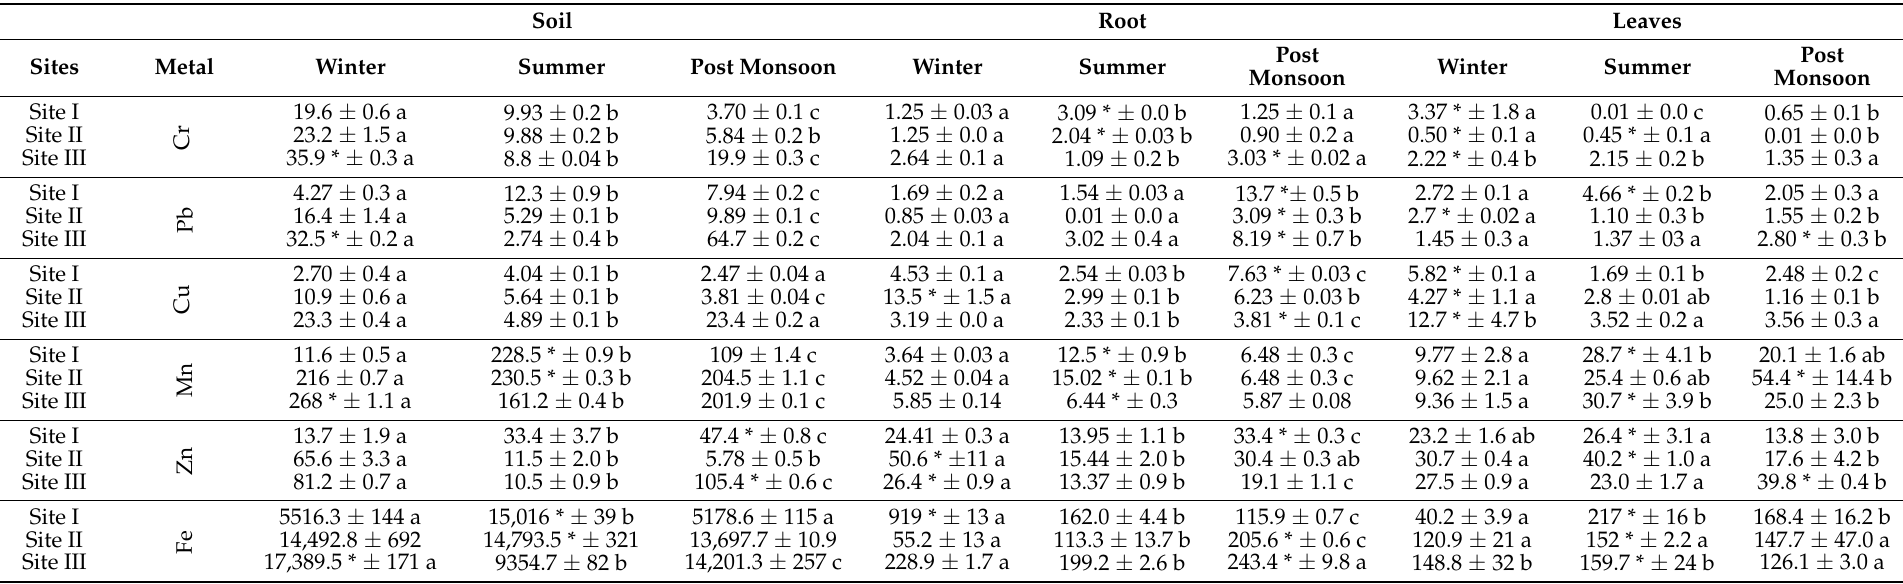
Table 1. Extractable metal concentration (mg kg − 1 ) in soil, root, and shoot of Salvadora persica at Sandspit (Site I), Clifton (Site II) and Korangi (Site III). Different letters on error bars indicate significant differences among seasons on the same site ( n = 3) at p ≤ 0.05 (Bonferroni/Games-Howell tests wherever applicable). Asterisk (*) in mean values represent the most significant data.